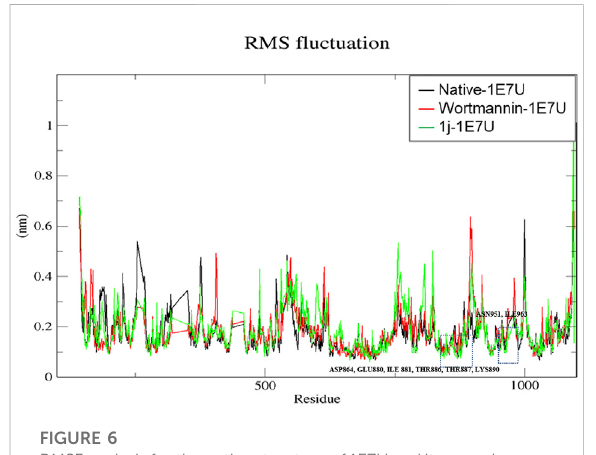
FIGURE 8 SASA analysis for the native structure of 1E7U (black) and its complex with Wortmannin (red) and 1j (green).